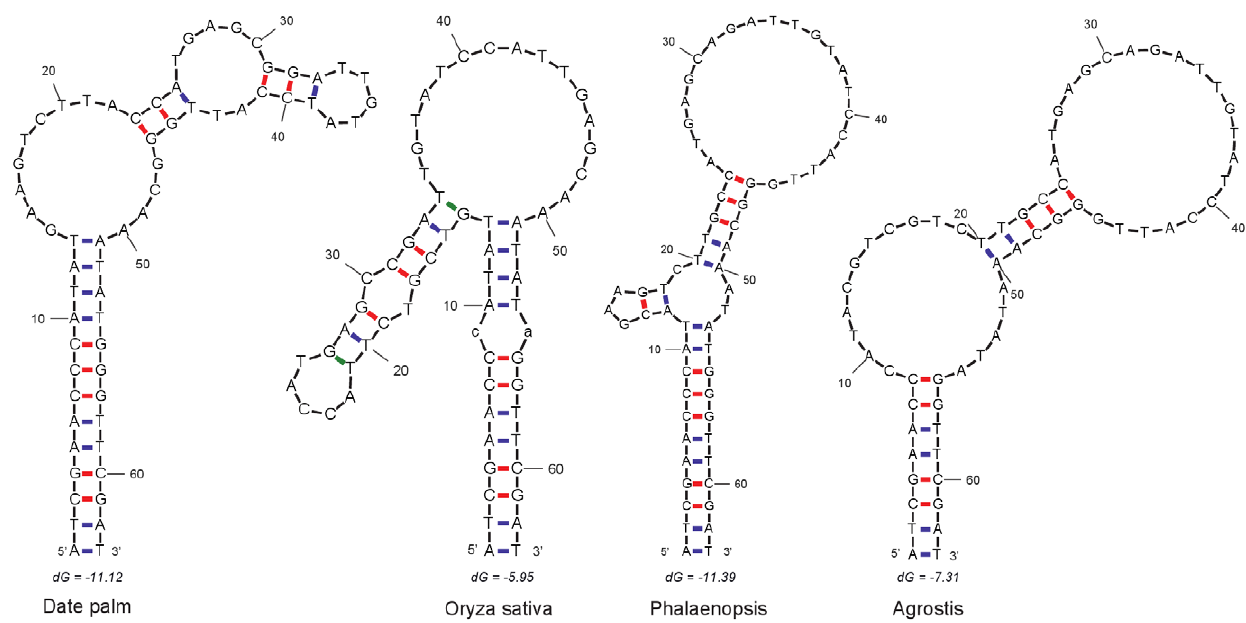
Figure 5. Folded stem-loop structures of the new SI from four representative species. Free energy values (dG) are shown for SI in each species.